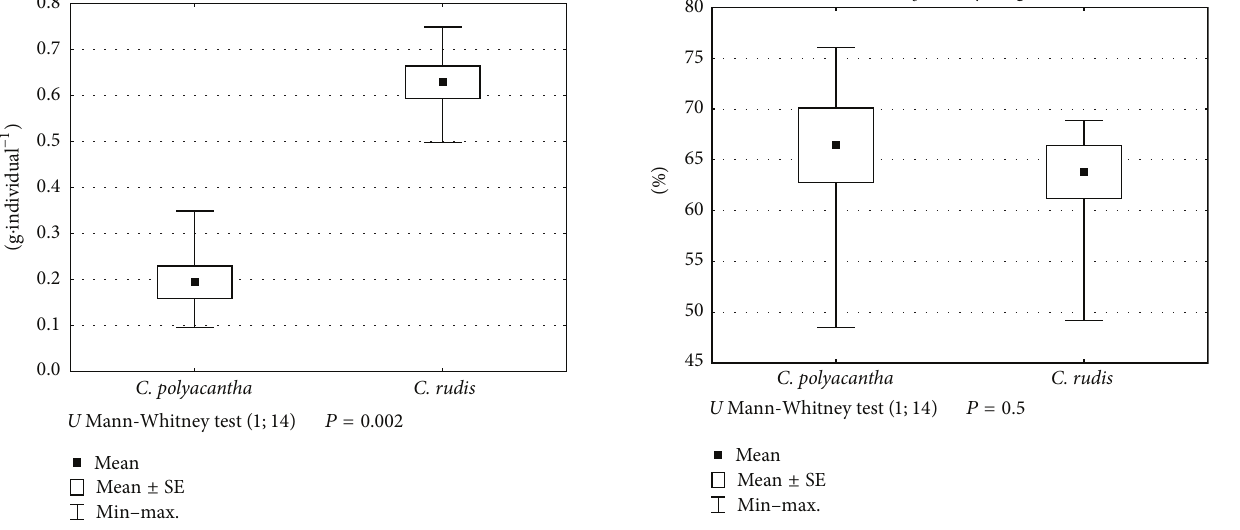
Figure 6: The differentiation between C. polyacantha and C. rudis against the percentage of CaCO 3− in dry